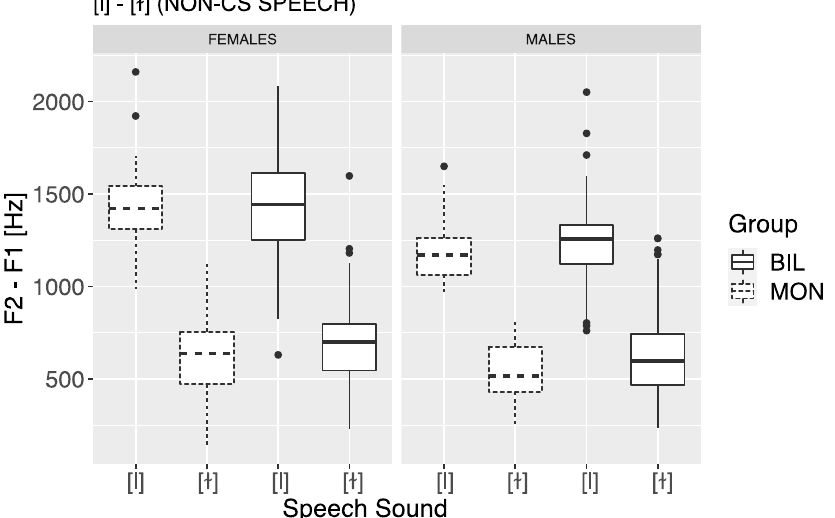
Figure 10. The distance between F1 and F2 of intended light [l] and dark [ ɫ ] sounds in English words, spoken by MON speakers (dashed) and BIL (solid) in non-CS speech. The left panel shows female data, the right panel male data.